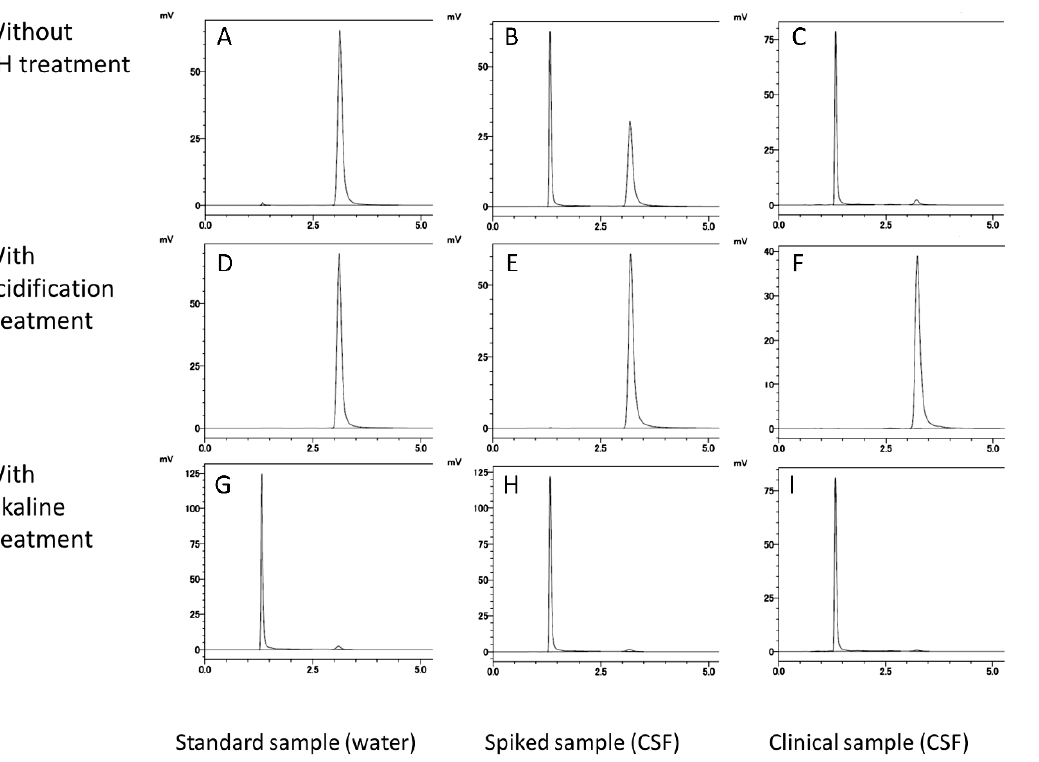
Figure 2. HPLC chromatograms of topotecan obtained under each pH adjustment condition. Topotecan stock solution diluted with water ( A , D , G ), topotecan-spiked CSF ( B , E , H ), and clinical CSF samples ( C , F , I ) were analyzed using the developed HPLC method. In the first step of sample preparation, samples were mixed with water ( A – C ), HCl aquation ( D – F ), or NaOH aquation ( G – I ).